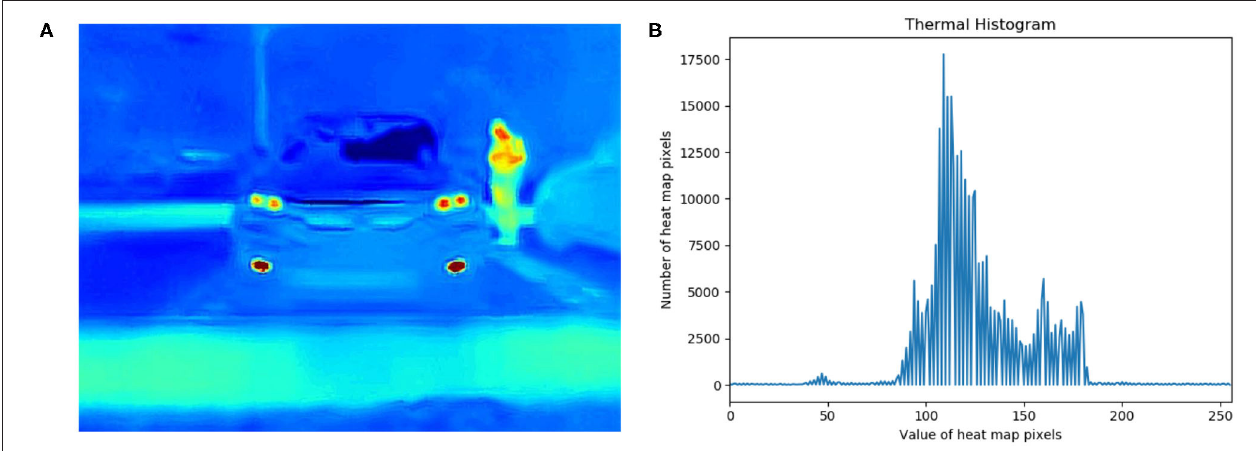
FIGURE 12 | Thermal histogram and thermal image after dynamic adjustment. (A) Thermal image after dynamic adjustment. (B) Thermal histogram after dynamic transformation.